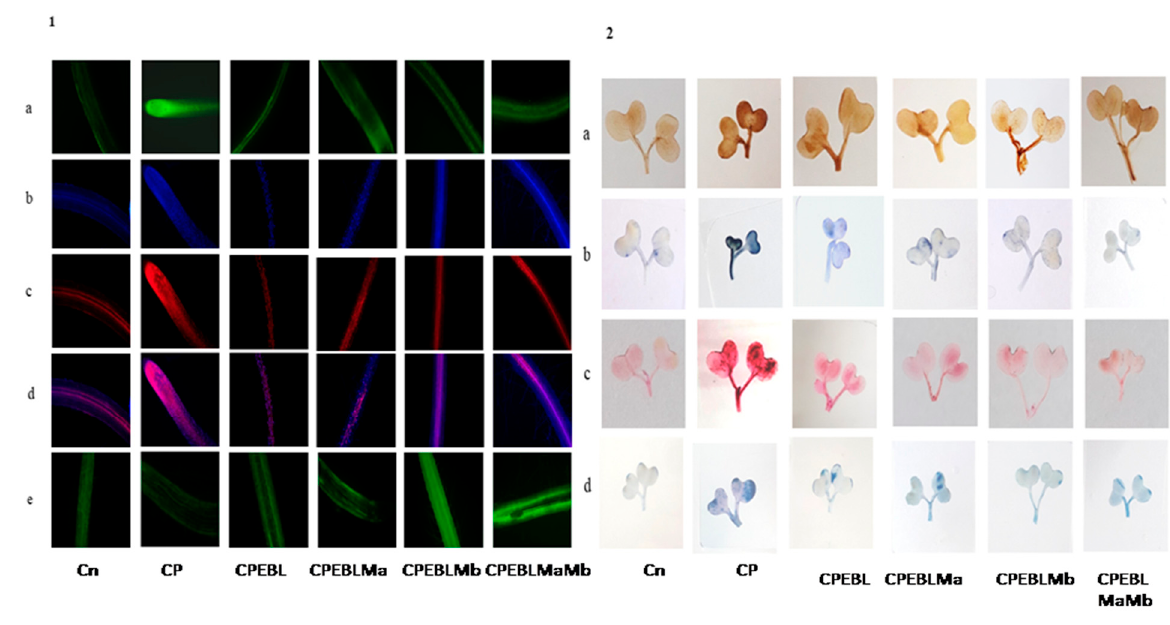
Figure 2. ( 1 ) In situ visualisation of B. juncea roots indicating the generation of: ( a ) H 2 O 2 tagged with DCF-DA, the green color intensity represents the level of H 2 O 2 ; ( b ) nuclear damage exposed with DAPI, the blue dots represent the nuclear damage; ( c ) membrane damage tagged with PI, the red color dots represents the membrane damage; ( d ) their interlay, dark pink color represent the maximum nuclear damage and membrane damage; and e) NO, intense green color represents high level of nitric oxide in roots of B. juncea . ( 2 ) In situ visualisation of B. juncea leaves indicating the generation of ( a ) H 2 O 2 exposed with DAB, brown color indicating the H 2 O 2 formation, ( b ) O 2 − tagged with NBT, blue color signifying the production of O 2 − . ( c ) Lipid peroxidation uncovered with Schiff’s reagent, pink color representing the lipid peroxidation. ( d ) Membrane integrity tagged with Evan’s blue, blue color indicating the loss of membrane integrity in B. juncea L. seedlings. (Note: Cn—without CP control, CP—chlorpyrifos, EBL—24-epibrassinolide, Ma— Pseudomonas aeruginosa and Mb— Burkholderia gladioli ).